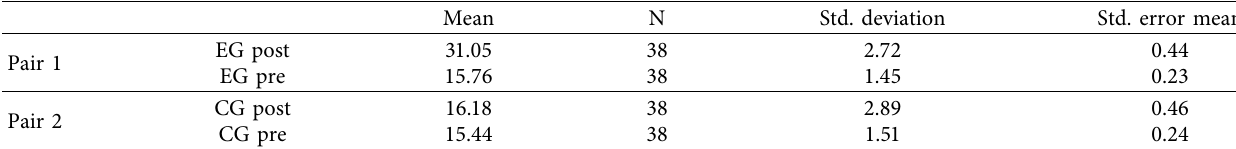
Table 6: Results of descriptive statistics (pretest and posttest of EG and CG).